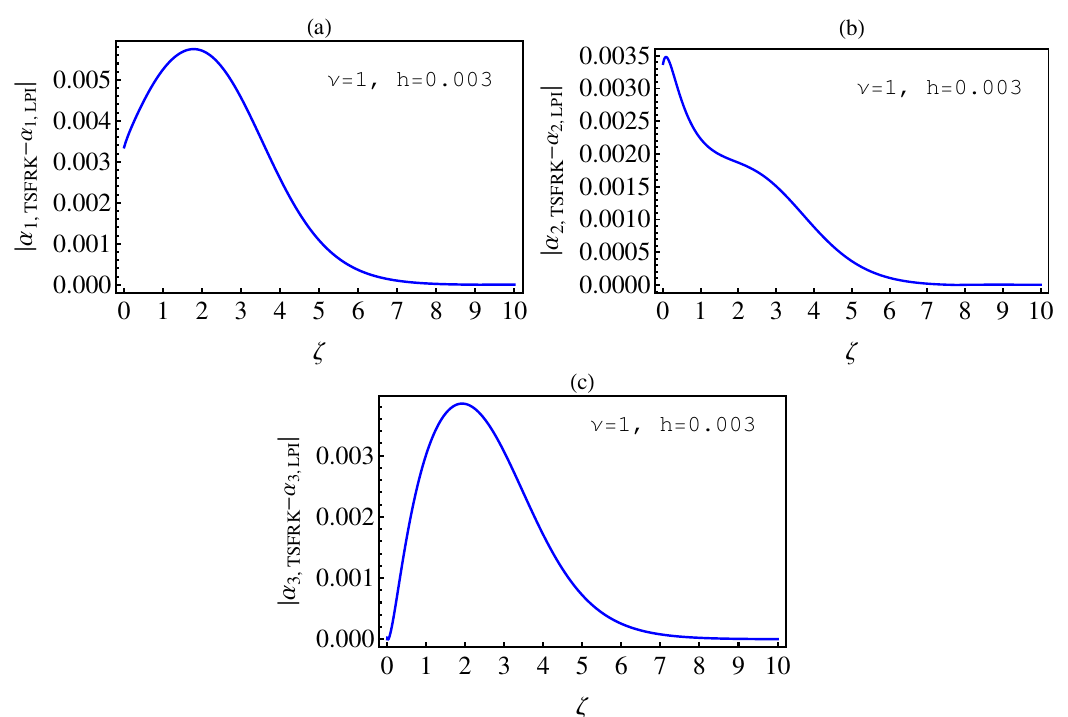
Figure 5. The absolute error between the numerical solutions of (2) to (4) based upon: the LPI and the FSFRK for ν = 1, h = 0.03, m = 21, λ = 2, (cid:101) = 1, µ = 2, δ = 1 and for the initial values α 1 ( 0 ) = 0, α 2 ( 0 ) = 1 and α 3 ( 0 ) = λ (( a ), ( b ) and ( c ),